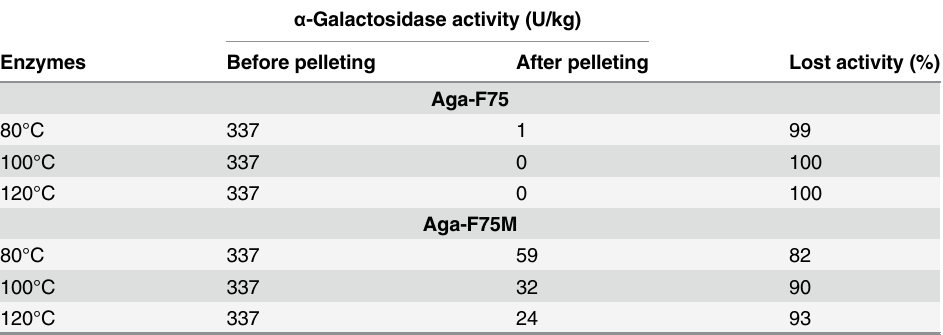
Table 1. Thermostability of Aga-F75 and Aga-F75M during feed pelleting a . α -Galactosidase activity (U/kg) Enzymes Before pelleting After